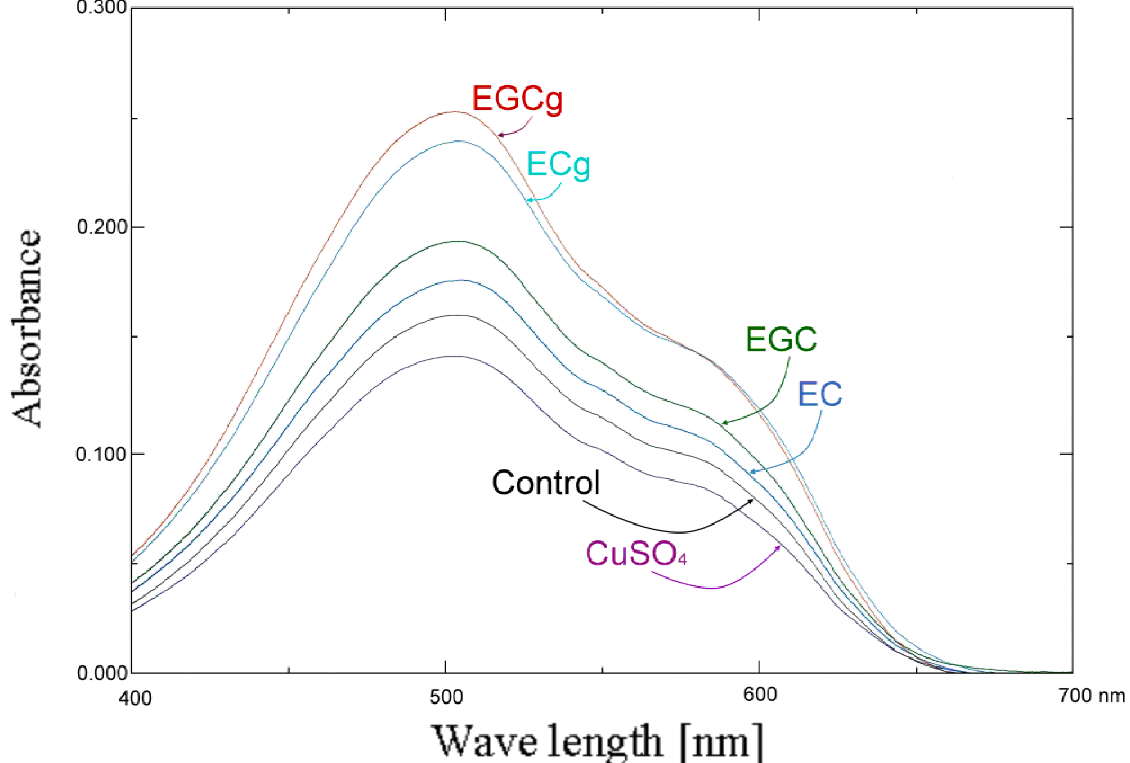
Fig. 2 Full spectrum of various MTT/DMSO solutions pertaining to cells incubated for 30 min with copper sulfate, EC, ECg, EGC and EGCg, 1 mM respectively. Control group was incubated only in saline. MTT incubation time was 45